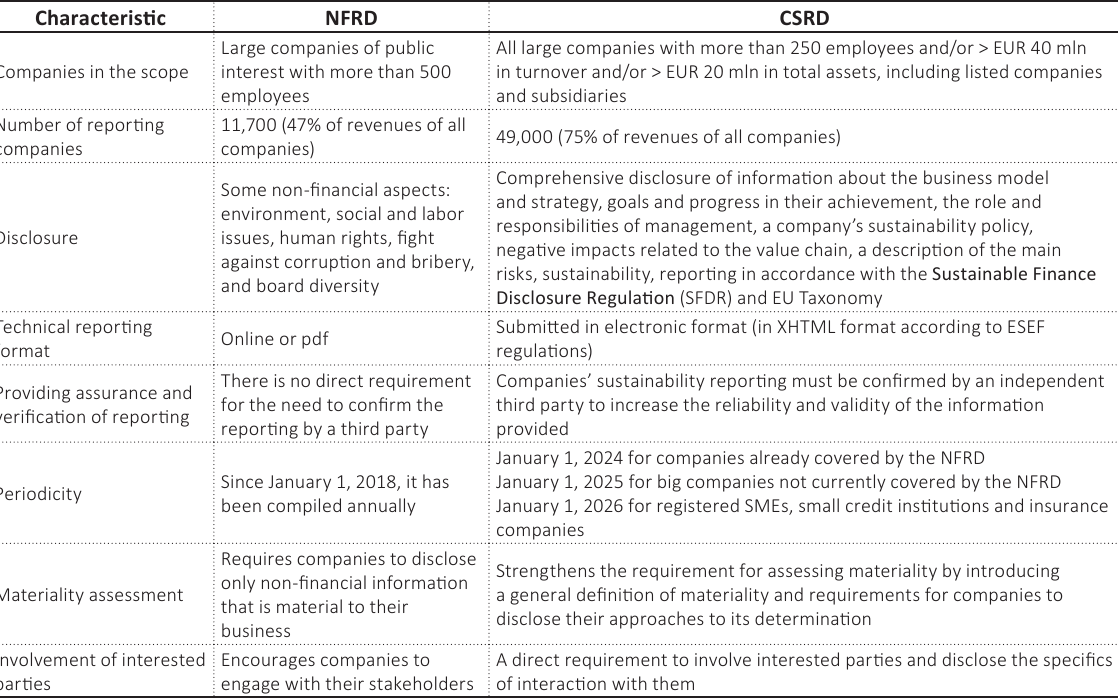
Source: Compiled based on data from Deloitte